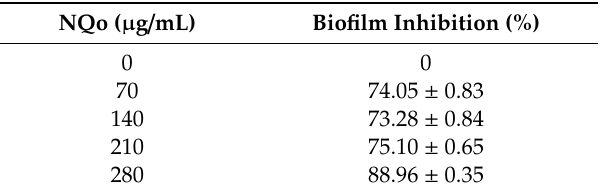
Figure 3. E ff ect of sub-MICs of NQo on Pseudomonas sp. biofilm formation at 37 ◦ C: ( A ) Quantification Figure 3. Effect of sub-MICs of NQo on Pseudomonas sp . biofilm formation at 37 °C: ( A ) Quantification of biofilm formation; ( B ) control and NQo MIC treatment (280 µ g / mL) wells. *** p < 0.001 indicates of biofilm formation; ( B ) control and NQo MIC treatment (280 μ g/mL) wells. *** p < 0.001 indicates statistical significance as compared to the control. statistical significance as compared to the control. Table 2. Biofilm inhibition of Pseudomonas sp. treated with NQo. Table 2. Biofilm inhibition of Pseudomonas sp . treated with NQo.